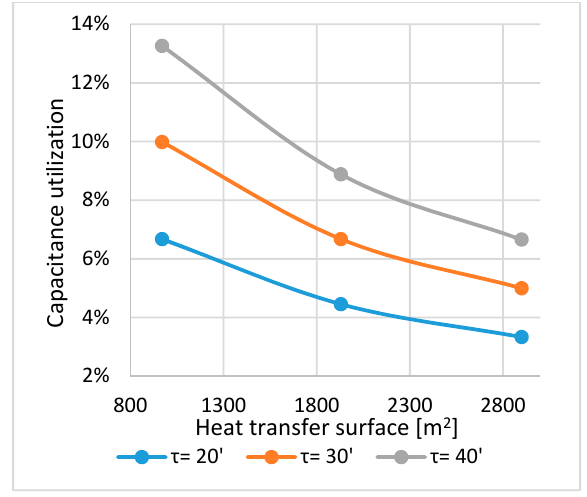
Figure 8. Capacitance of utilization variation for different RC sizing and inversion time.